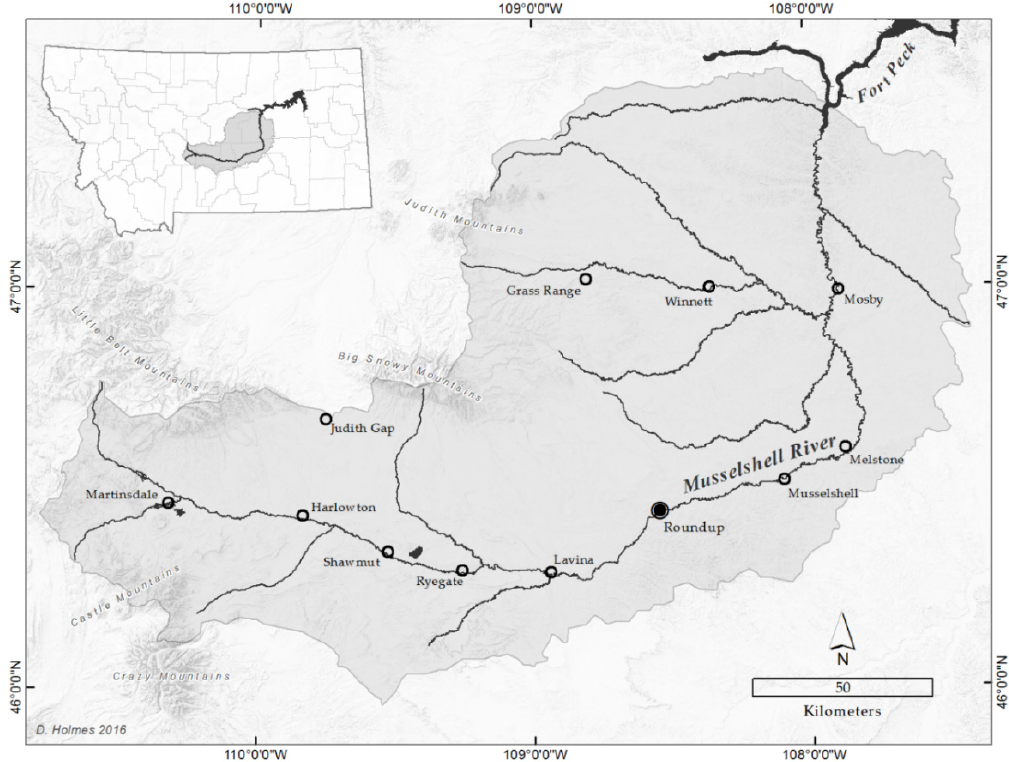
Figure 1. The Musselshell River (MSR) and Basin, and the Basin’s most populous towns. The MSR flows west to east from the confluence of its North and South Forks and into Fort Peck Reservoir.